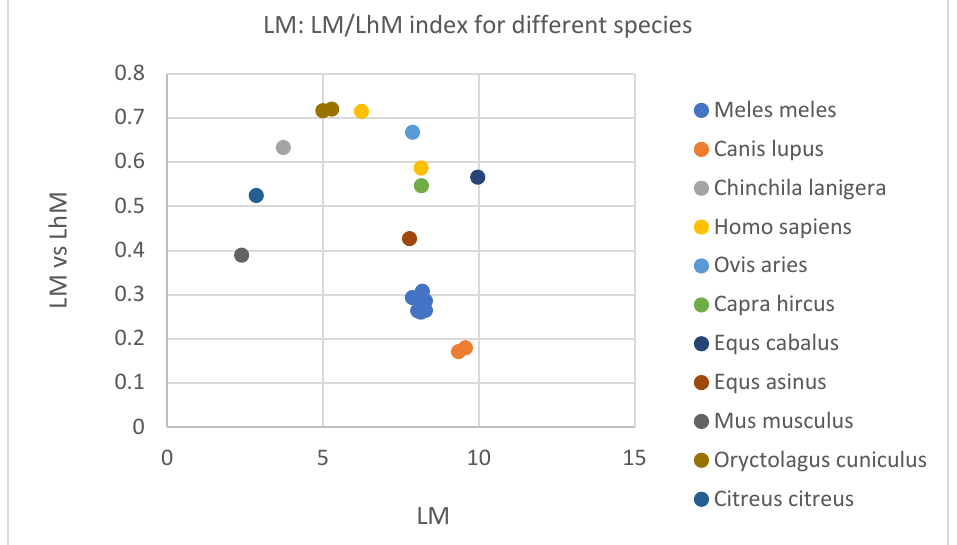
Figure 7. Graphical representation of the malleal length vs. the index calculated as a fraction of LM from LhM for different species.